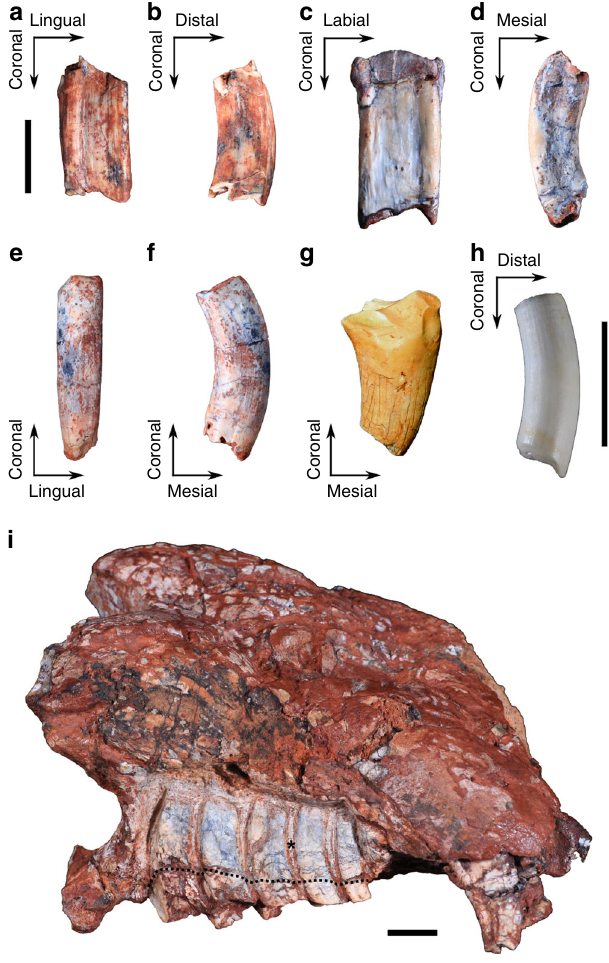
Fig. 1 Menadon besairiei postcanine dentition. Upper postcanine UFRGS-PV- 1333-T. a distal view; b labial view. Upper postcanine MCN-PV-10221 T, c distal view; d labial view. Lower postcanine MCN-PV-10343 T in, e mesial view; f labial view. g Exaeretodon riograndensis MCN-PV-3101 T. Heavily worn right lower postcanine in labial view. h , Extant xenarthran, three-toed sloth Bradypus sp. MCN-2771. Second upper molariform in lingual view. i , Menadon besairiei UFRGS-PV-1165-T. Right maxilla with the postcanine dentition exposed. Asterisk marks a location of periodontal space. Dotted line represents the original limits of the alveoli. Scale bars equal 10